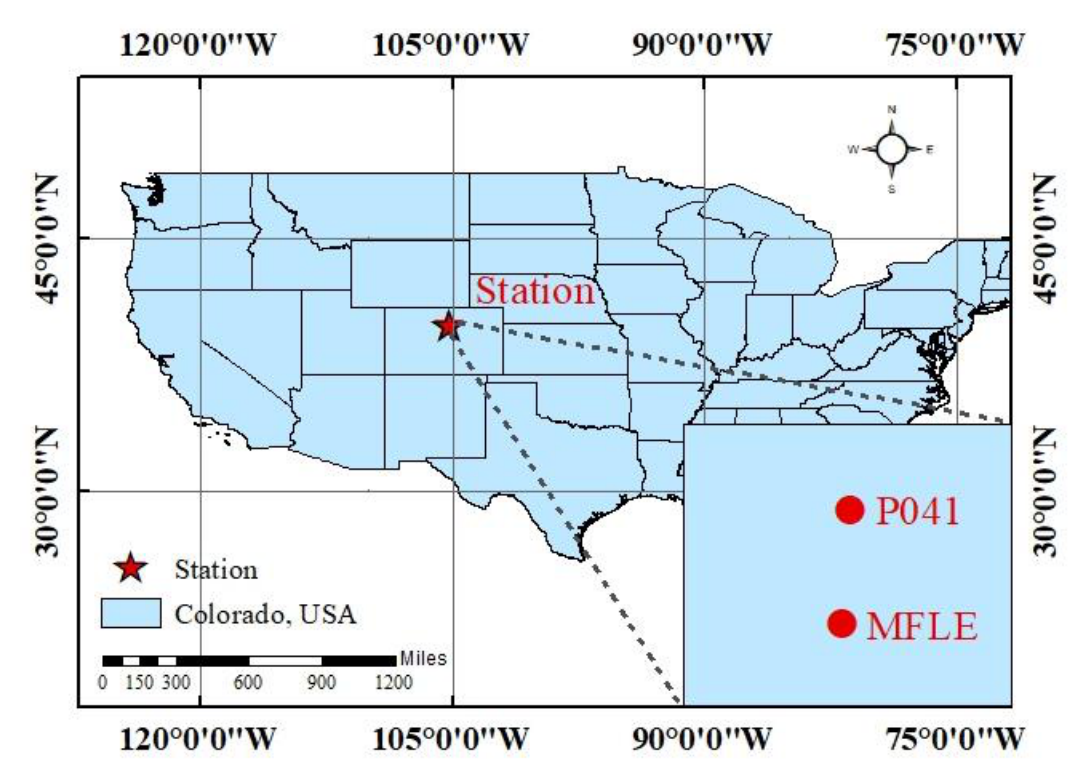
Figure 2. GNSS test site locations. P041 and MFLE stations, Boulder, CO, USA.